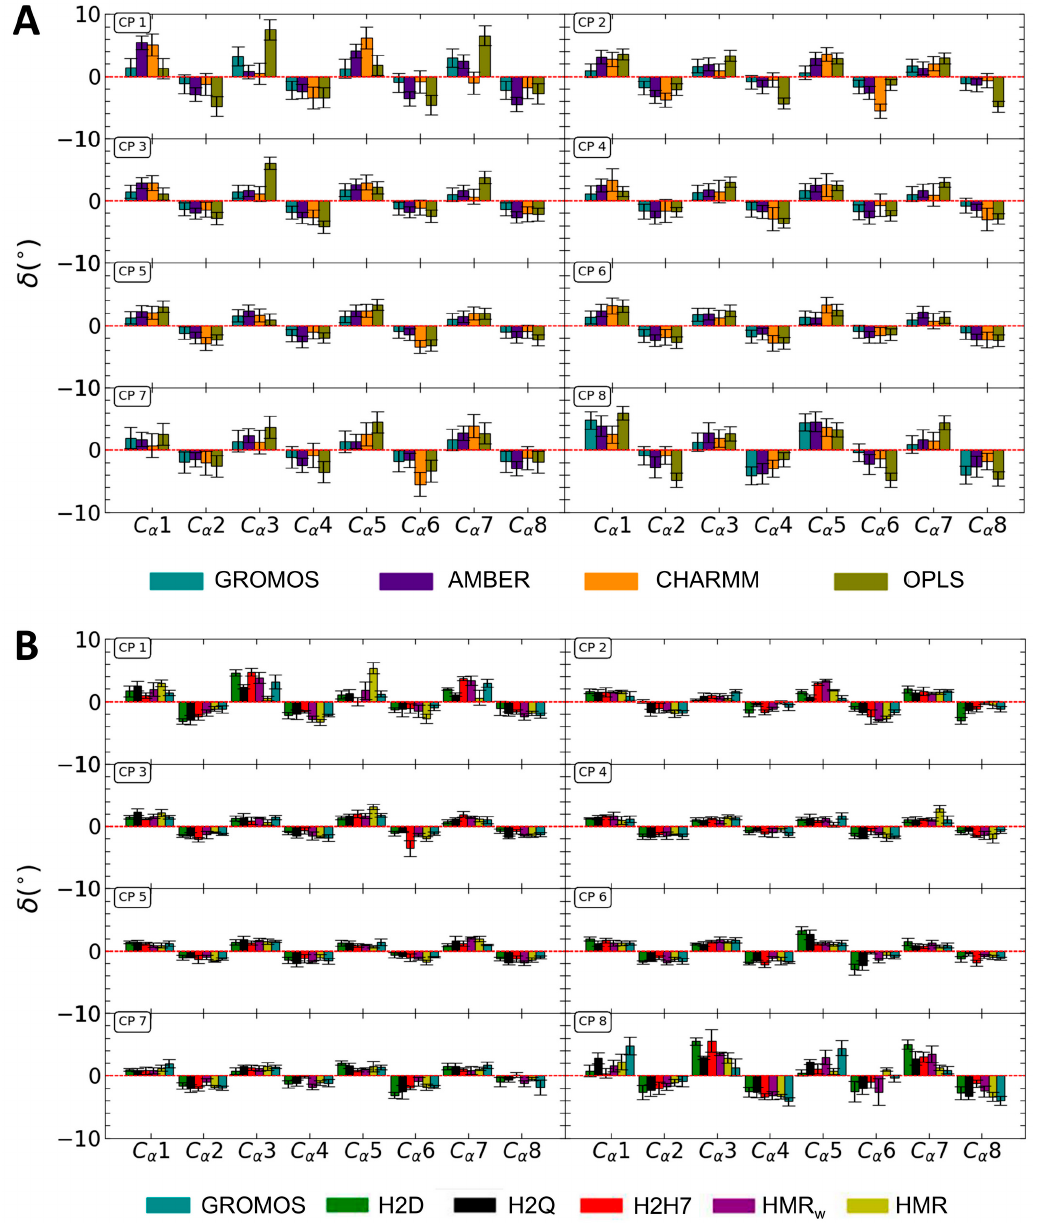
Figure 4. Average values of the angles between the vectors joining each C α with the center of the CP and the CP plane for the unmodified force fields ( A ), and for the modified parameterizations of GROMOS ( B ). The uncertainties in the plot are the standard deviations obtained using the block average method [46], multiplied by 1.96 to get the values within a confidence interval of 95%.